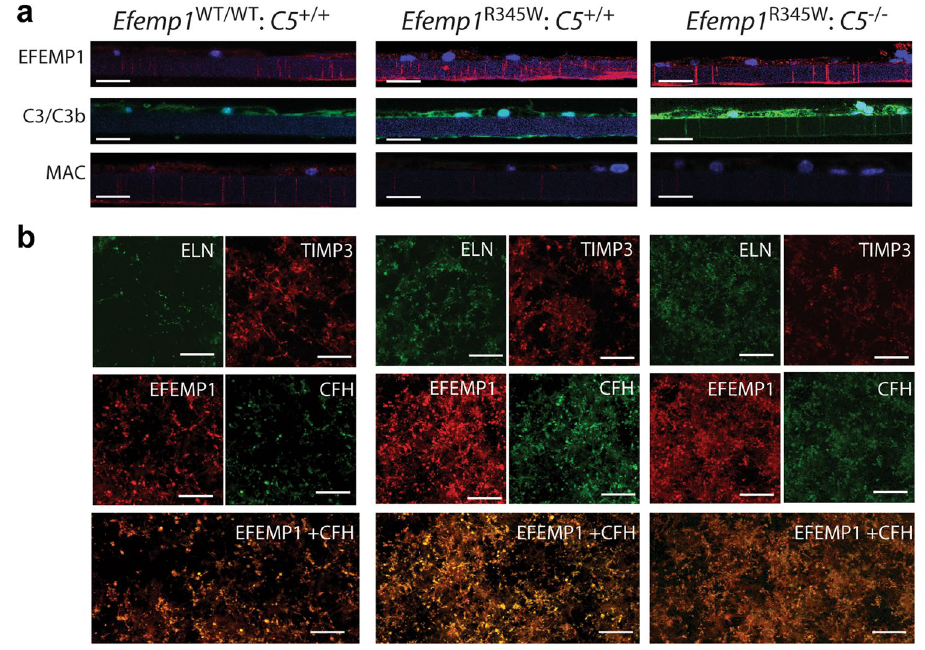
Figure 4. ( a ) Vibratome sections of primary mouse RPE cells Efemp1 WT/WT :C5 + / + , Efemp1 R345W/R345W :C5 + / + , and Efemp1 R345W/R345W :C5 -/- cultured on transwells for two weeks and immunostained with antibodies for EFEMP1, C3/C3b/iC3b/C3d and C3dg, MAC. Note positive C3 staining at the bottom of the insert in Efemp1 R345W/R345W :C5 + / + cultures and throughout the insert pores in Efemp1 R345W/R345W :C5 -/- cultures. This is due to the orientation of the sections. ( b ) Flat mounts of the bottom side of the inserts were immunostained with antibodies for ELN, TIMP-3, EFEMP1, CFH. EFEMP1 and CFH colocalize in the deposits. Scale bars a-i: 25 μm, j-aa: 100 μm.